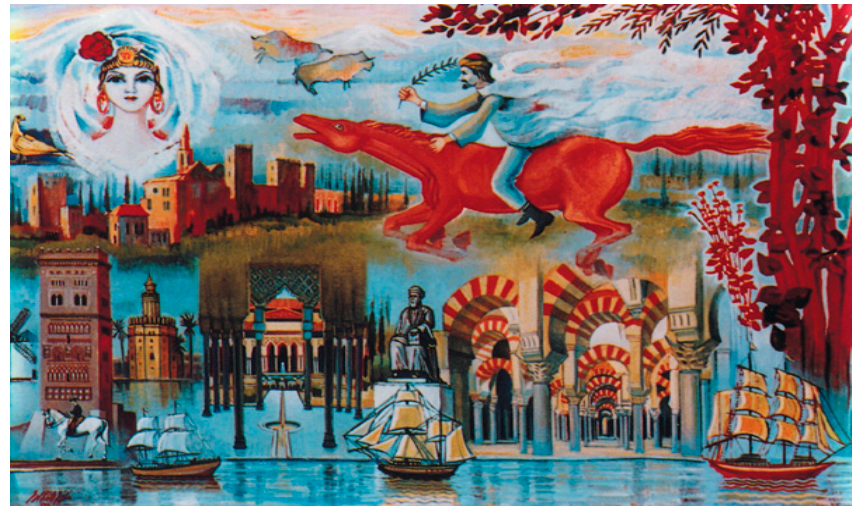
Figure 2. What the Arabs brought to Europe. (Oil on Canvas.) Source: Al-Khalidi (1990), open access. Arts 2019 , 8 , x FOR PEER REVIEW